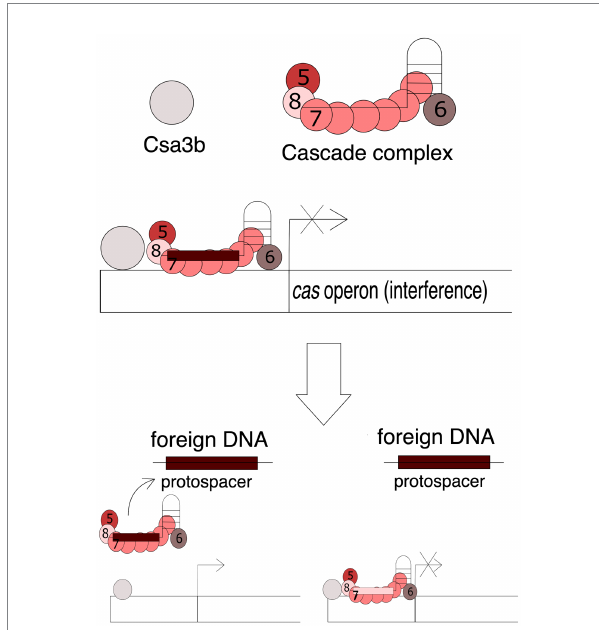
FIGURE 4 Mechanism of the Cas3b-Cascade action. The attachment of the Cascade complex is dependent on the Cas3b protein. Both Cas3b and Cascade bind to the promoter region of the cas genes encoding proteins involved in the interference phase, resulting in the inhibition of expression of these genes. Presence of foreign DNA, e.g., viral DNA, containing the complementary protospacer sequence causes the detachment of the complex and activation of gene